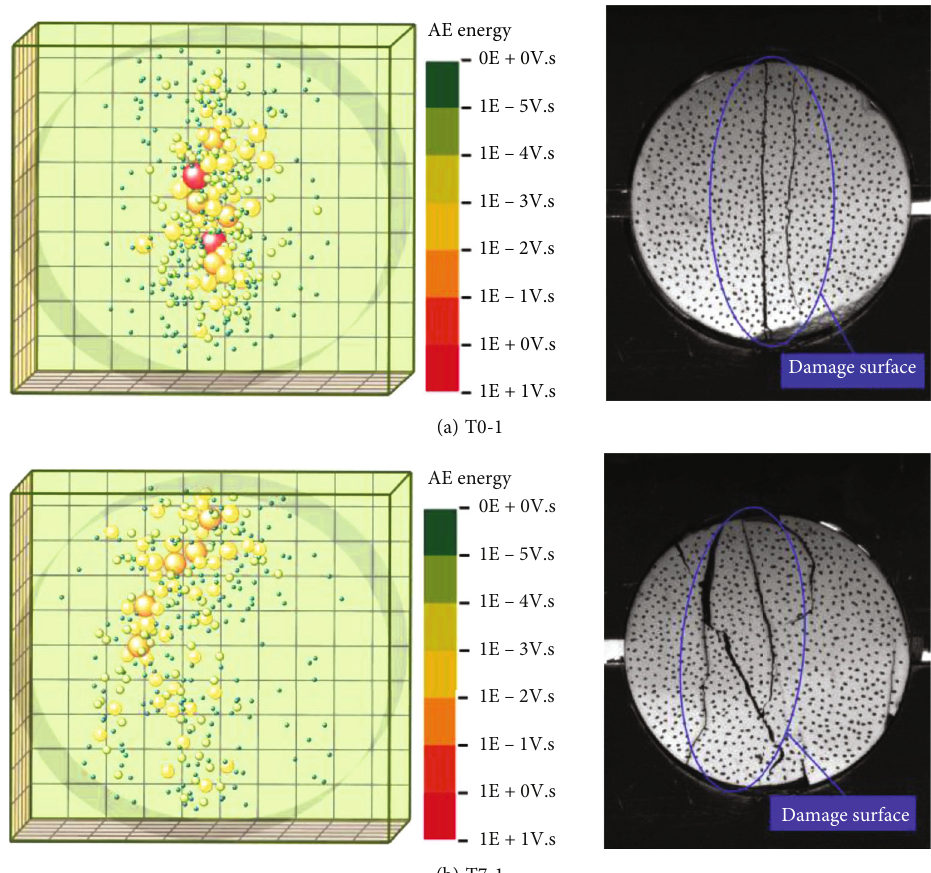
Figure 8: AE source location of rock samples and physical images in Brazilian indirect tensile